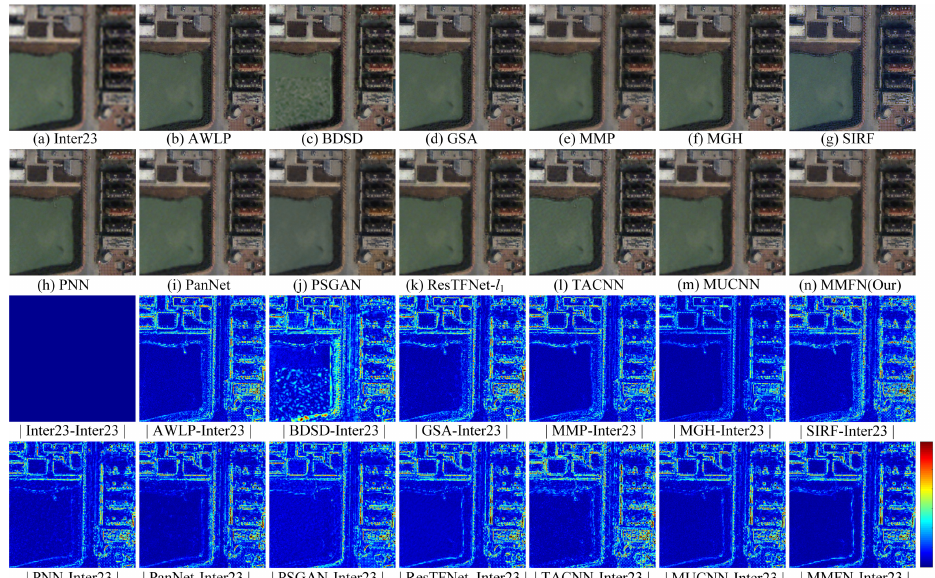
Figure 6. Qualitative comparison at full resolution on the QuickBird dataset. ( a ) Inter23, ( b ) AWLP, ( c ) BDSD, ( d ) GSA, ( e ) MMP, ( f ) MGH, ( g ) SIRF, ( h ) PNN, ( i ) PanNet, ( j ) PSGAN, ( k ) ResTFNet- l 1 , ( l ) TACNN, ( m ) MUCNN, ( n ) MMFN (Our). The last two rows are MAEs between the pansharpened results and the Inter23